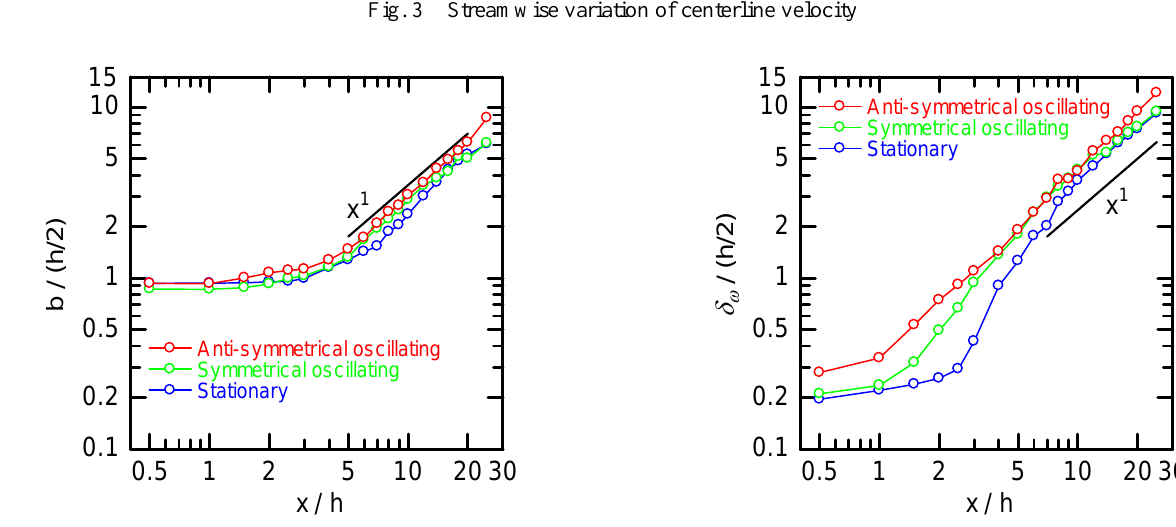
Fig. 4 Streamwise variation of half-width Fig. 5 Streamwise variation of vorticity